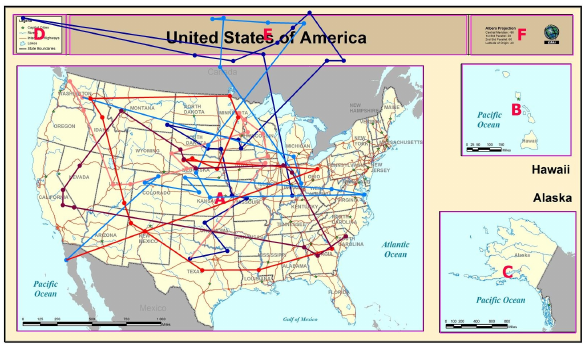
Figure 11. Trajectories of five participants making two cliques (based on parameter (cid:1868) (cid:3404) 0.8 ). Three participants dis- played in shades of red spent the whole time in the map field. Participants GIS6 and NOGIS4 (shades of blue) visited the map field and map